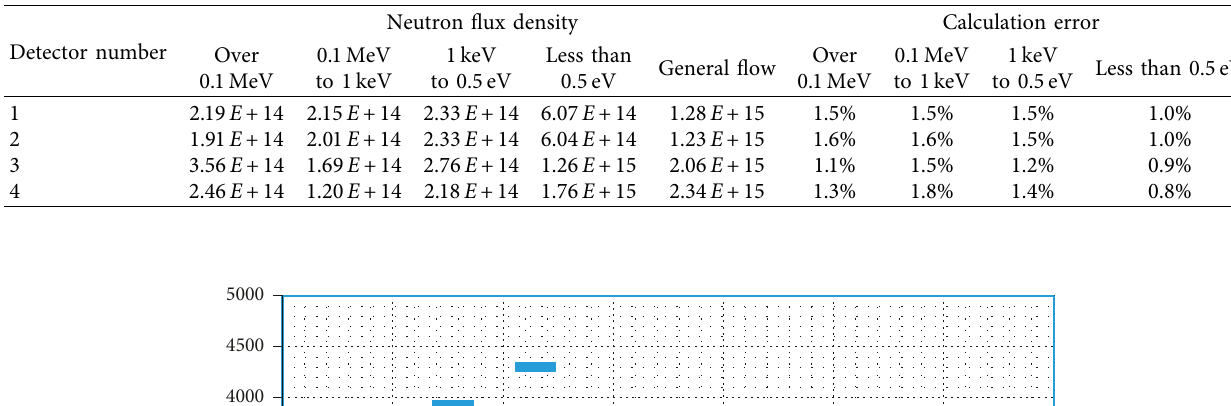
Figure 3: Diagram of core geometry with an indication of materials for neutron-physical calculation. Table 3: Calculated parameters of the neutron flux at control points.